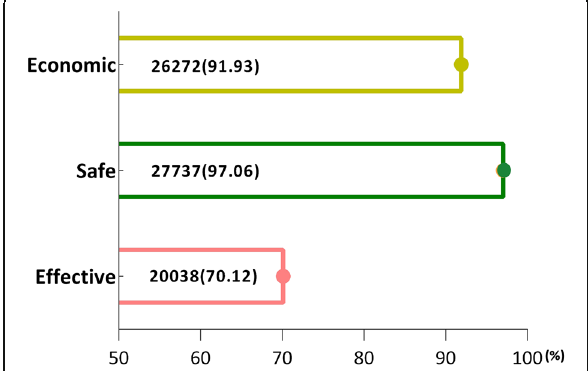
Fig. 6 National survey map of 2012 in China: traditional